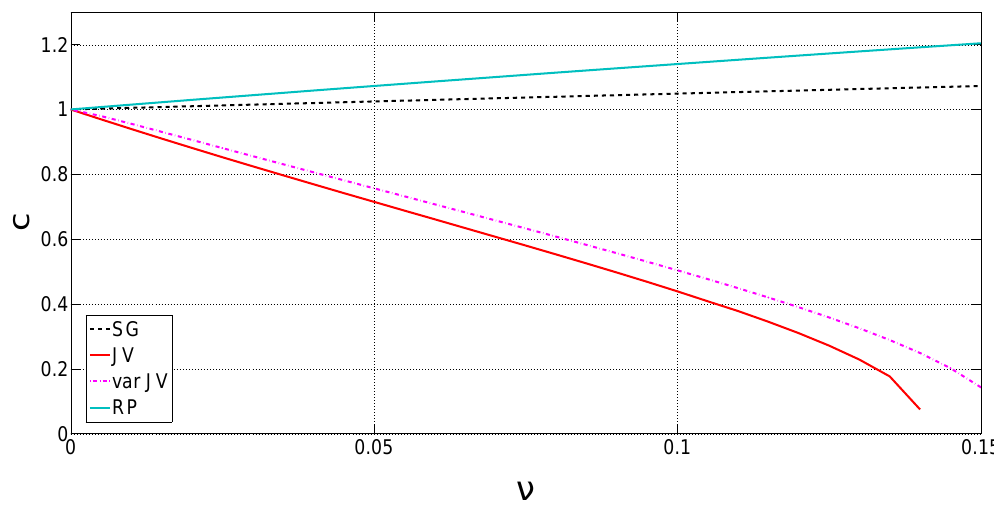
Figure 16: “Speed of light” from a relativistic dispersion relation for the sine-Gordon (labeled ‘SG’) and coupled BECs models (labeled ‘JV’) at γ = 1. The magenta dash-dotted line is an approximate result obtained from a variational calculation for Josephson vortices (labeled ‘var = c JV’). Note that for γ = 1, c , the speed of sound, and the elementary “speed of light” SG B c is added as a solid cyan line (upper). RP